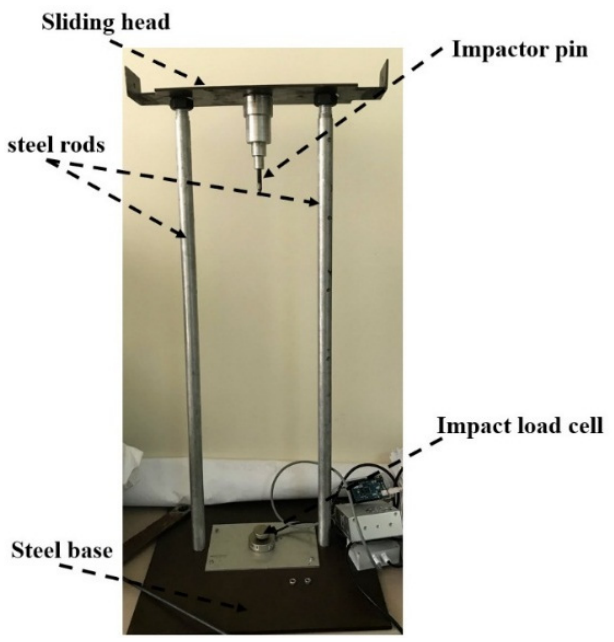
Figure 5. Simple drop weight impact tester.